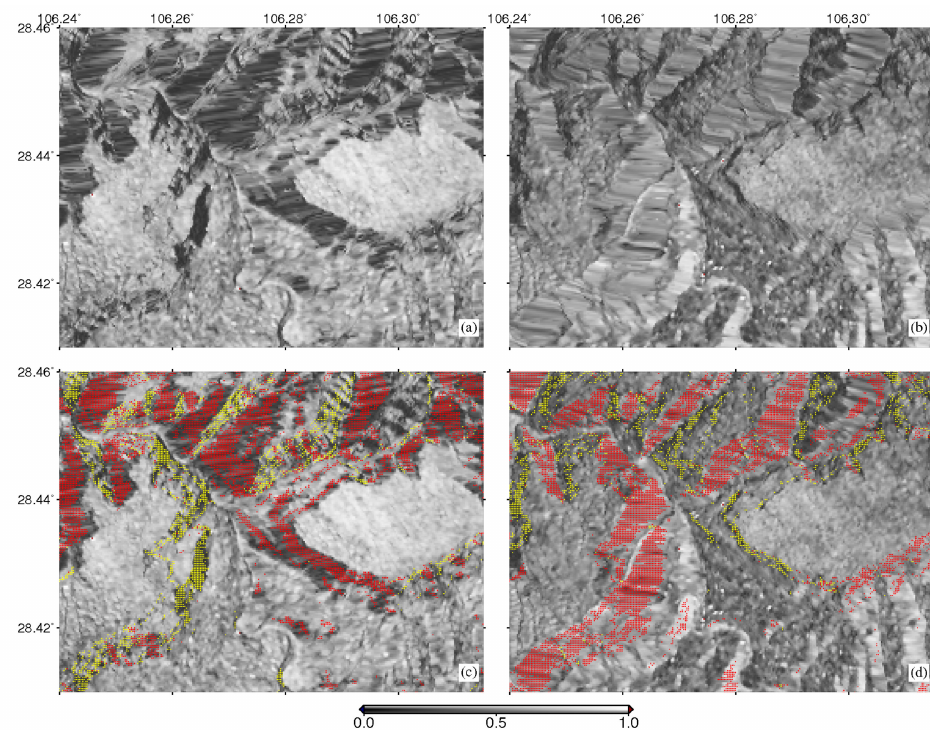
Figure 7. Coherence maps derived from the ALOS ascending data ( a , c ) and the ALOS descending data ( b , d ); the red points represent the layover and the yellow points represent shadow.